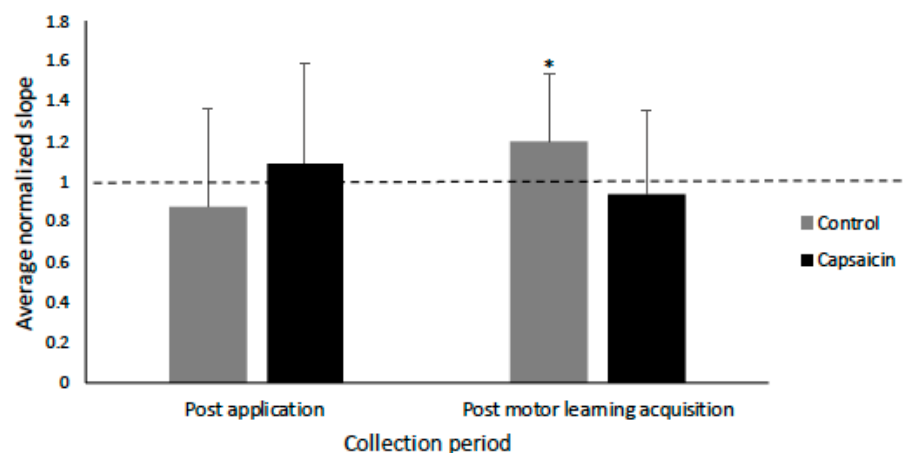
Figure 6. Bar-graph depicting the normalized average slope post-application and post-motor learning acquisition for the control and capsaicin groups. There was a significant increase in slope for the control group ( p < 0.05) following motor learning acquisition as indicated by an asterisk. Error bars represent the standard deviation.